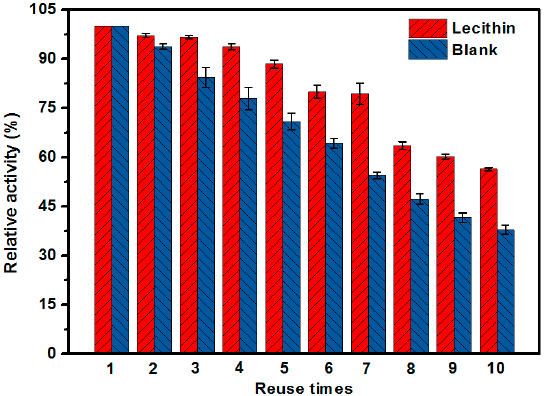
Figure 10. Reusability of the EMBR. (The two EMBRs were prepared under optimal conditions according to the above data. Test condition: 105.6 L·m − 2 ·h − 1 of membrane flux, 0.2 M substrate solution, T = 25 °C).